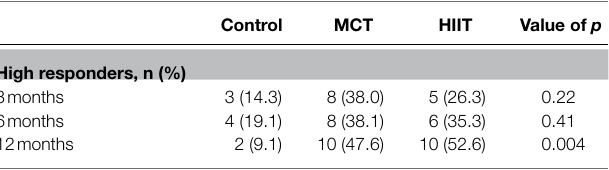
TABLE 2 | Proportion of individuals in experimental groups who reduced body fat mass at different time